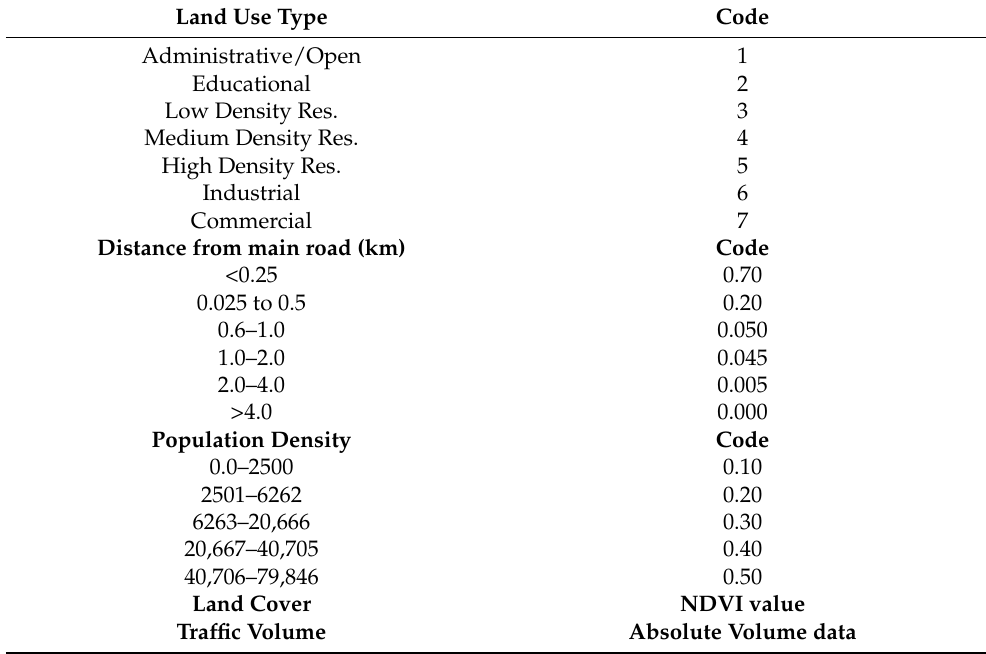
Table 2. Variable Used and Their Ranking for the Modelling.